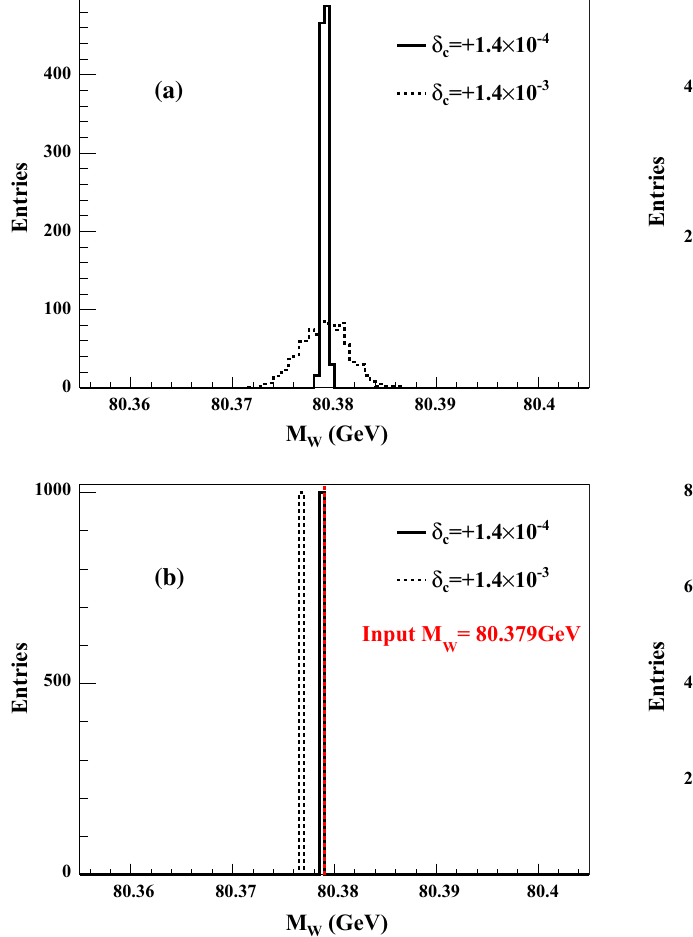
Fig. 8 The simulation results of m W for the Gaussian (a) and non- Gaussian (b) cases, with the input m W of 80.379 GeV. The black solid and dash lines are for δ c = + 1 . 4 · 10 − 4 and δ c = + 1 . 4 · 10 − 3 at 161.2 GeV, respectively